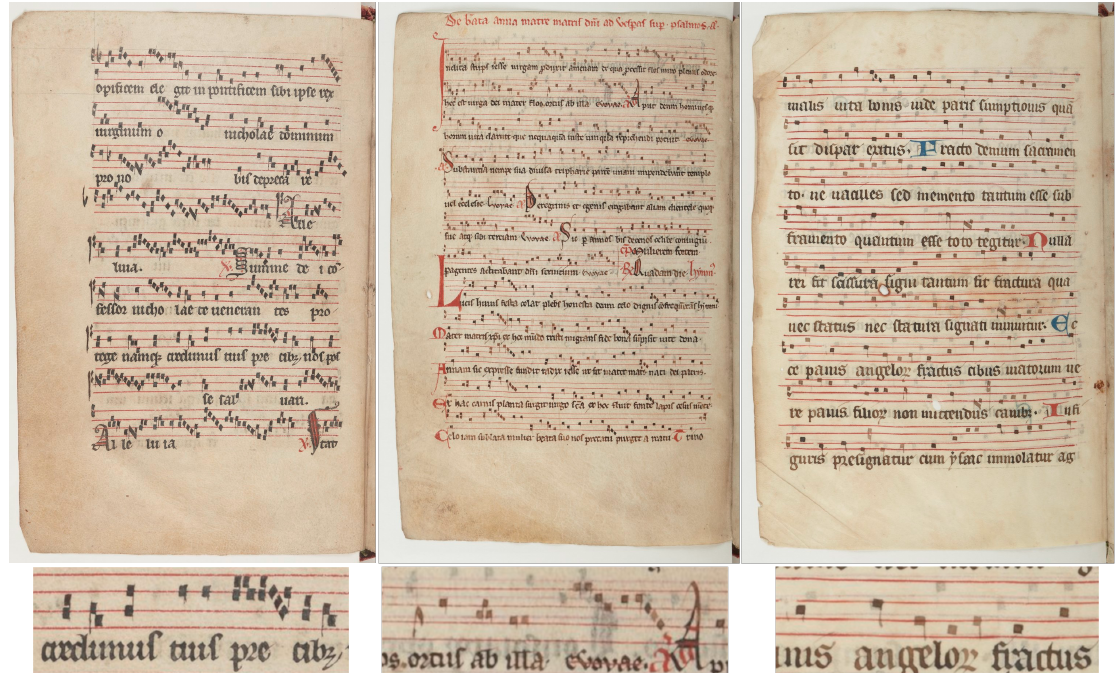
Figure 2. Each page represents parts 1, 2, and 3, respectively. The bottom images provide a zoomed view on the upper pages. While the first page is very clean, both other pages suffer from bleeding and fainter writing. The staff lines in the first and second part are very straight most certainly due to usage of a ruler, whereas the staff lines of the third part are freehand